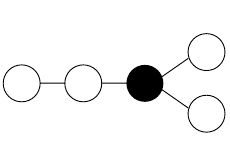
Figure 6 . The central node of D 5 .